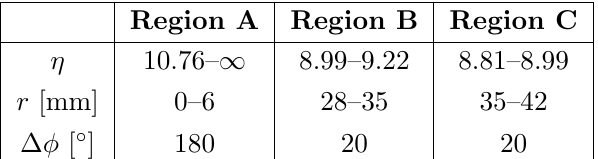
Table 2 . De(cid:12)nition of the three pseudorapidity regions used in the analysis: (cid:17) is the pseudorapidity, r is the distance from the beam center in the detector plane and (cid:1) (cid:30) is the azimuthal angle coverage.